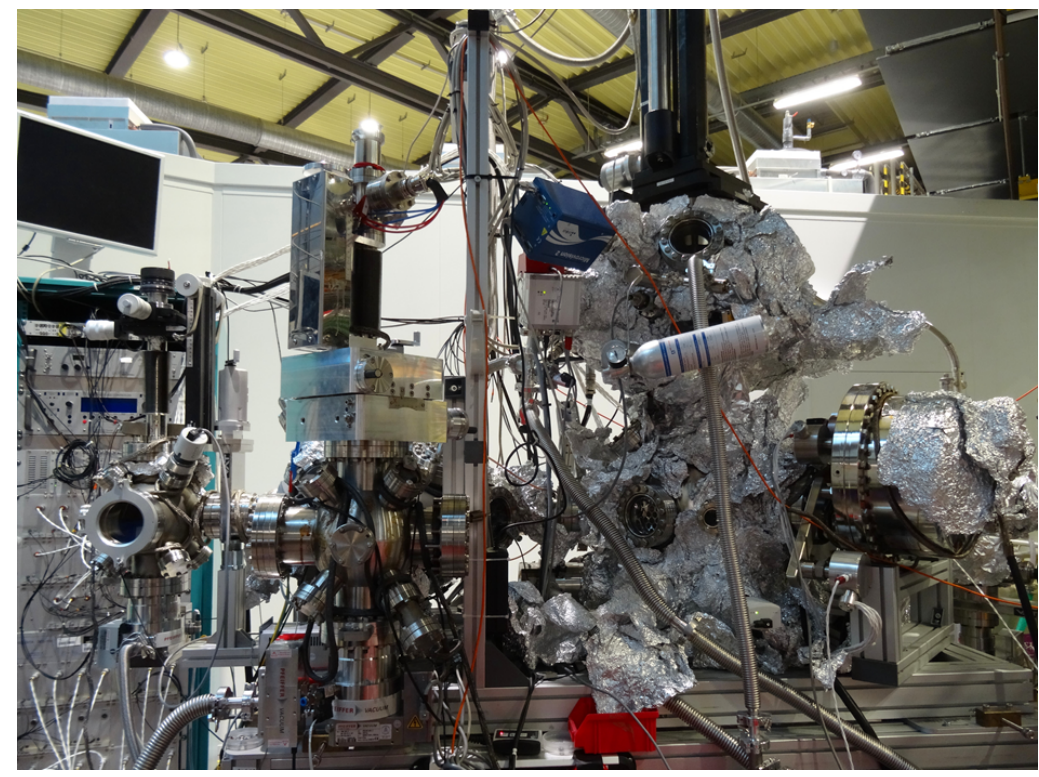
Figure 1: View of the LowDose PES